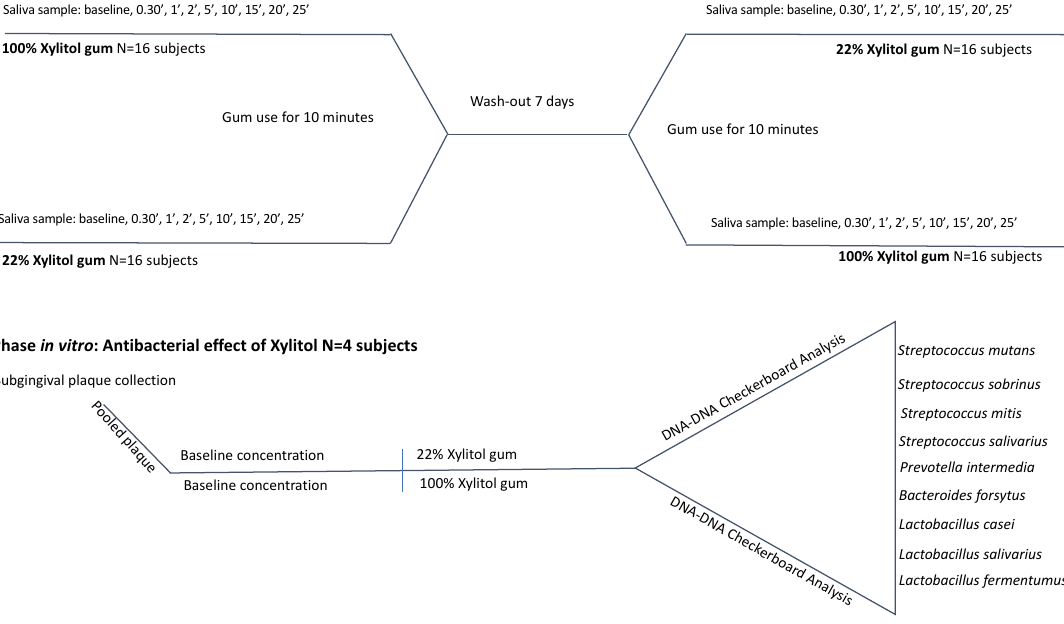
Figure 1. Flow-chart of the study design (in vivo and in vitro phases).